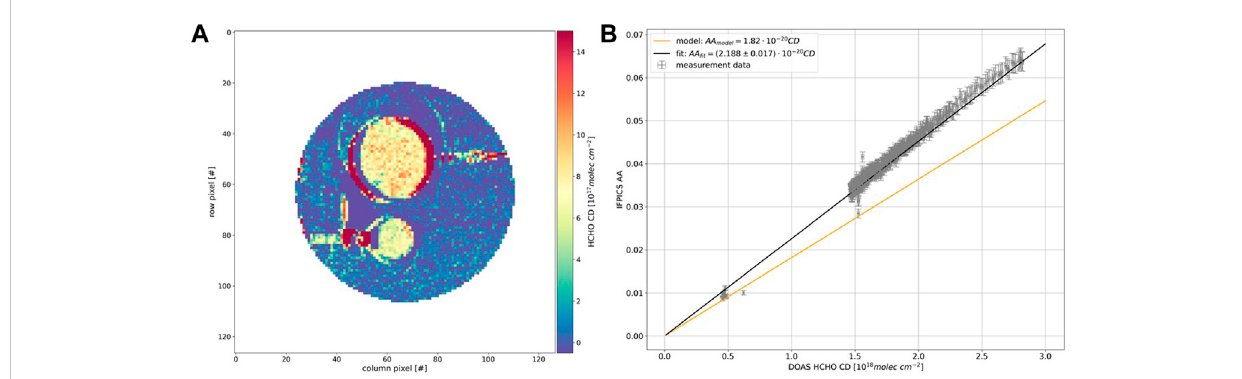
FIGURE 4 (A) Imaging measurement of two HCHO gas cells (Ø 50 mm and Ø 22 mm) with the IFPICS instrument from 19th of September 2020 at 08:03 UTC using scattered skylight as a light source. The measurement has a time resolution of 3 s and 8 × 8 pixel binning has been applied, resulting in an approximate spatial resolution of 80 × 80 pixels. The color scale shows the HCHO CD calibrated with a co-aligned DOAS measurement. (B) Calibration curve for the HCHO measurement shown in panel (A) . The DOAS instrument measures the CD inside the small gas cell and the DOAS calibration curve (black line) is compared to the model prediction (orange line). The gap between values around 5 × 10 17 molec cm − 2 and 1.5 × 10 18 molec cm − 2 originates from heating the gas cell, where the low CD measurements are prior to heating of the cell. The deviation between model prediction and measurement calibration is around 17%, possibly caused by errors in the DOAS evaluation, re fl ections at the cell, or slight misalignment of the DOAS telescope